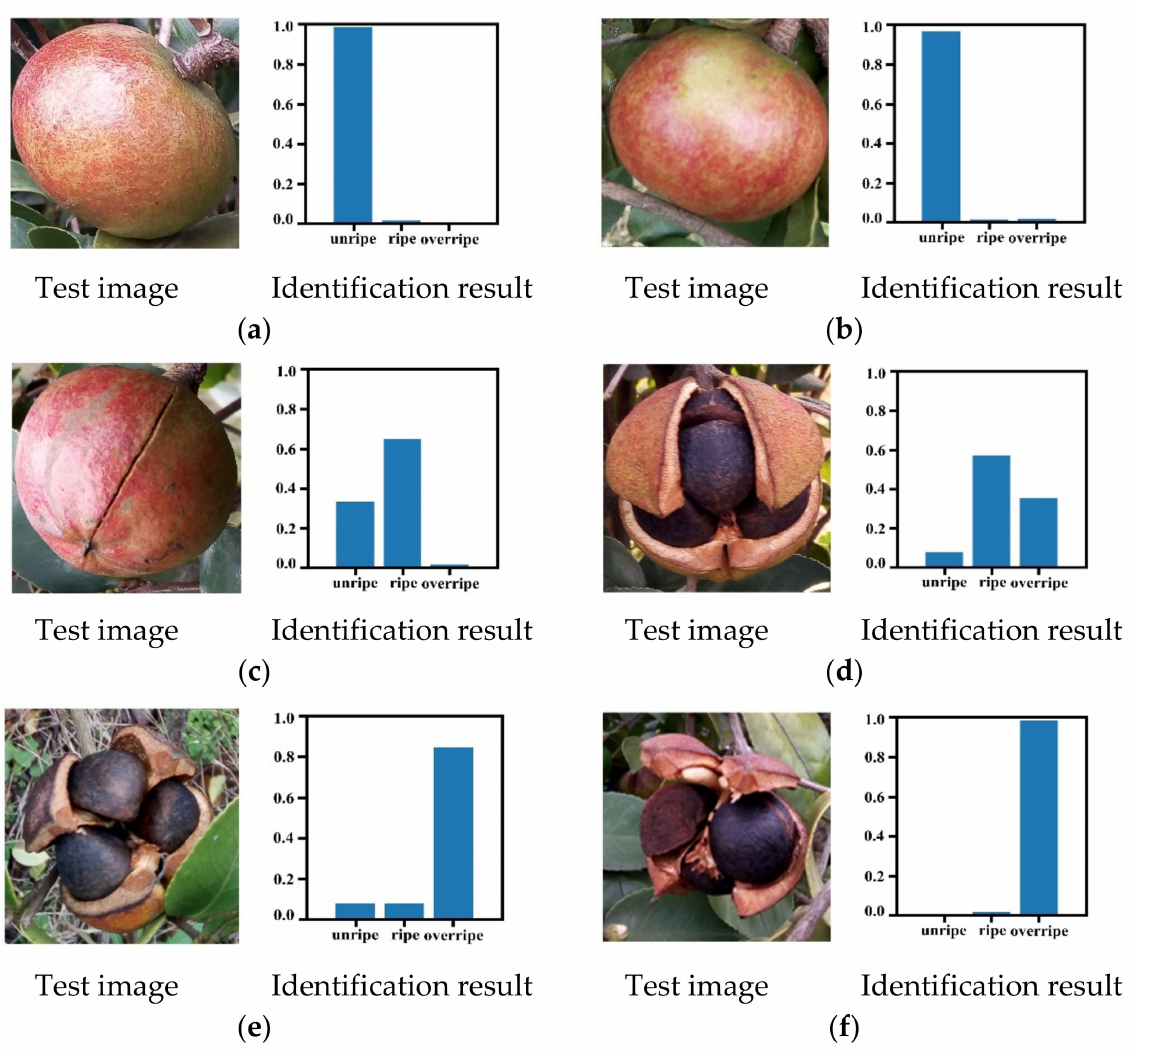
Figure 7. Maturity identification results of some Camellia oleifera fruit example images in testing set: ( a , b ) denotes maturity identification results of unripe Camellia oleifera fruits, ( c , d ) denotes maturity identification results of ripe Camellia oleifera fruits, ( e , f ) denotes maturity identification results of overripe Camellia oleifera